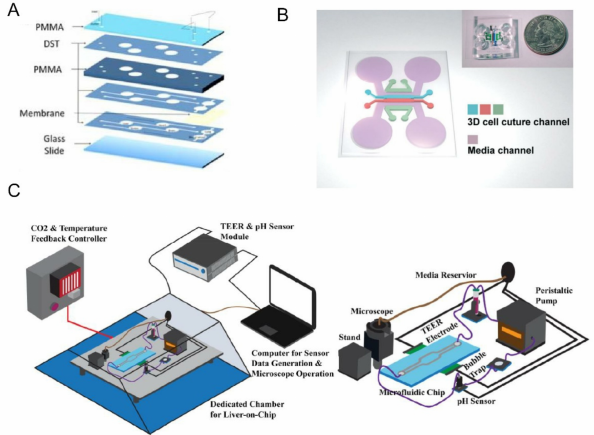
Figure 6. ( A ) Microfluidic devices were fabricated in a PDMS-free approach by layering PMMA and adhesive films with chambers, channels, and ports formed by laser cutting. Organoids were incorporated by being immobilized in hydrogels within each chamber. Semi-porous membranes enabled inclusion of planar vascular and lung modules. Reprinted with permission from Ref.